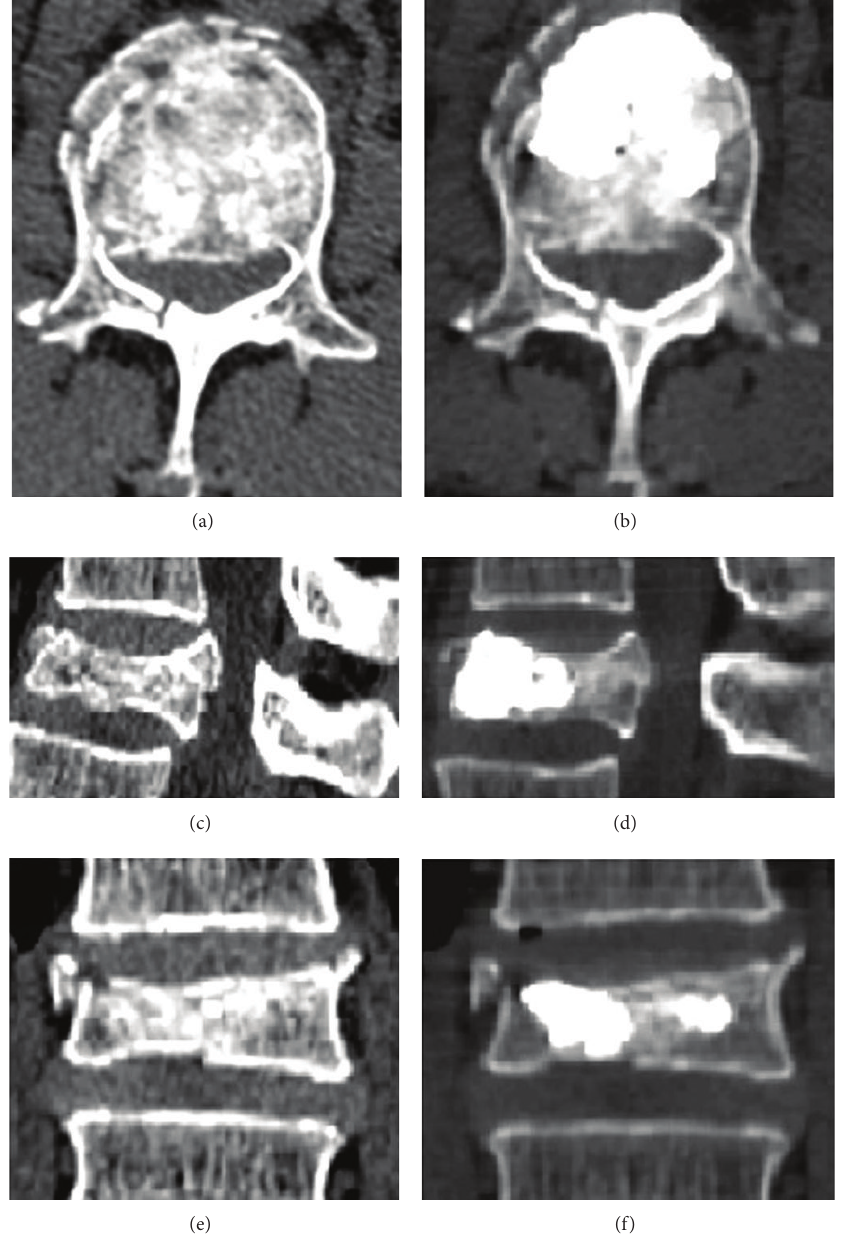
Figure 2: Pre-(left) and post-(right) procedure CT control in axial (top), sagittal (middle), and coronal (bottom) multiplanar reformations showing the good cement distribution throughout the anterior two-thirds of the collapsed vertebral